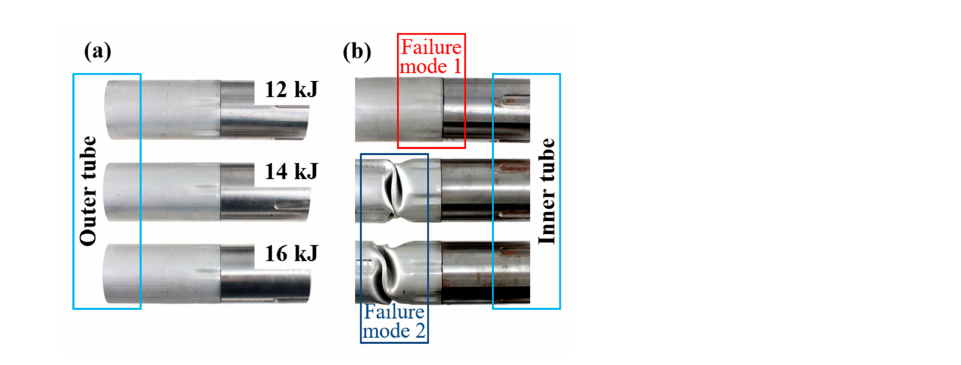
Figure 6. Samples of the electromagnetic crimping joints: ( a ) after process experiments; ( b ) after torsion tests.